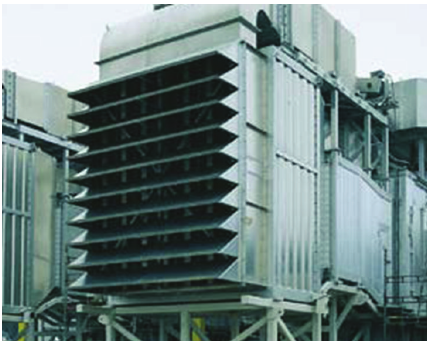
Figure 4: Weather Hood on inlet filtration system